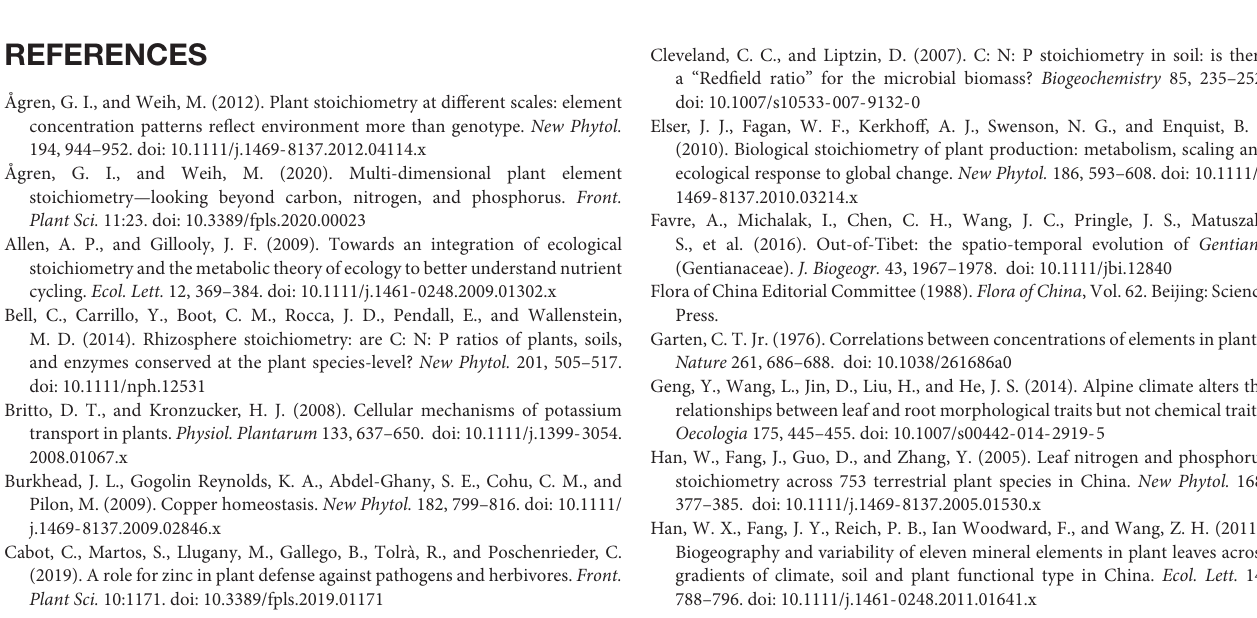
TABLE S1 | Information of the sampling sites. FIGURE S1 | The contribution of quantitative variables (in%) to the first dimension of the multiple factor analysis. FIGURE S2 | The contribution of quantitative variables (in%) to the second dimension of the multiple factor analysis. DATA SHEET S1 | The dataset for this